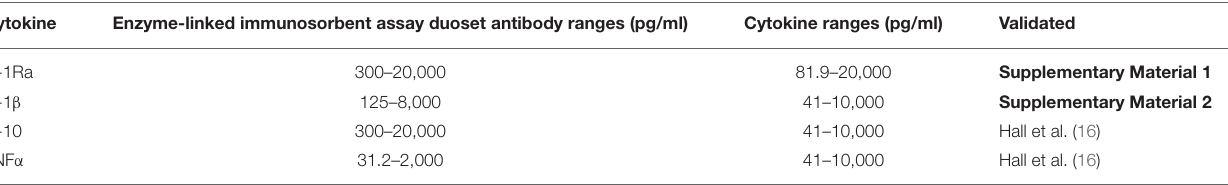
TABLE 3 | Validation method for fluorescent microsphere immunoassay. Cytokine Enzyme-linked immunosorbent assay duoset antibody ranges